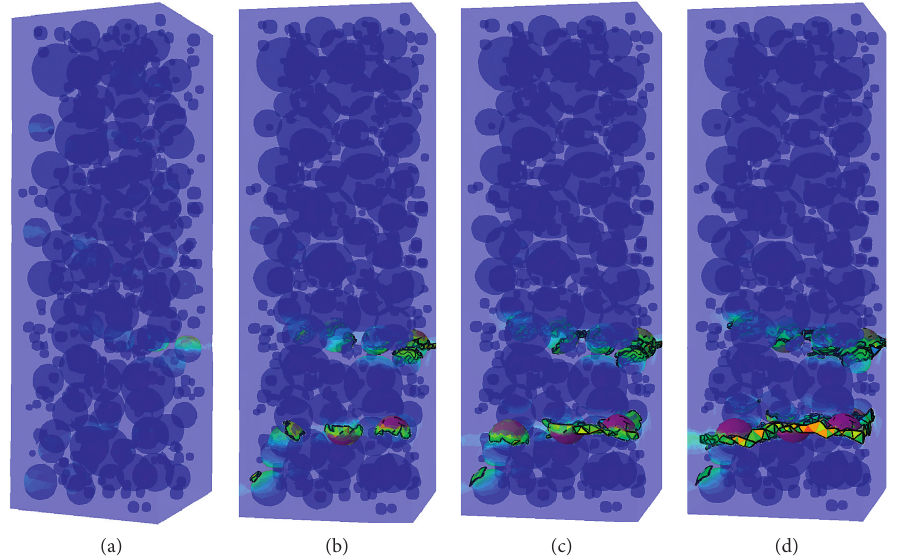
Figure 16: Crack development process of the type II crack ( p is the peak stress; 0 . 8 p , 0 . 6 p and 0 . 4 p are all corresponding postpeak loading phases). (a) p . (b) 0 . 8 p . (c) 0 . 6 p . (d) 0 . 4 p